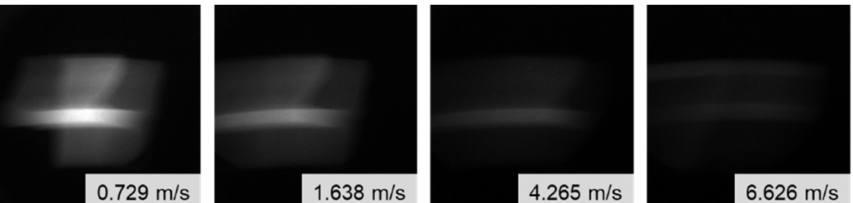
Figure 13. Snapshots of digit “4” in motion at different speeds captured by using a 60-fps camera with an exposure time of 1/60 s (see Visualization S1).